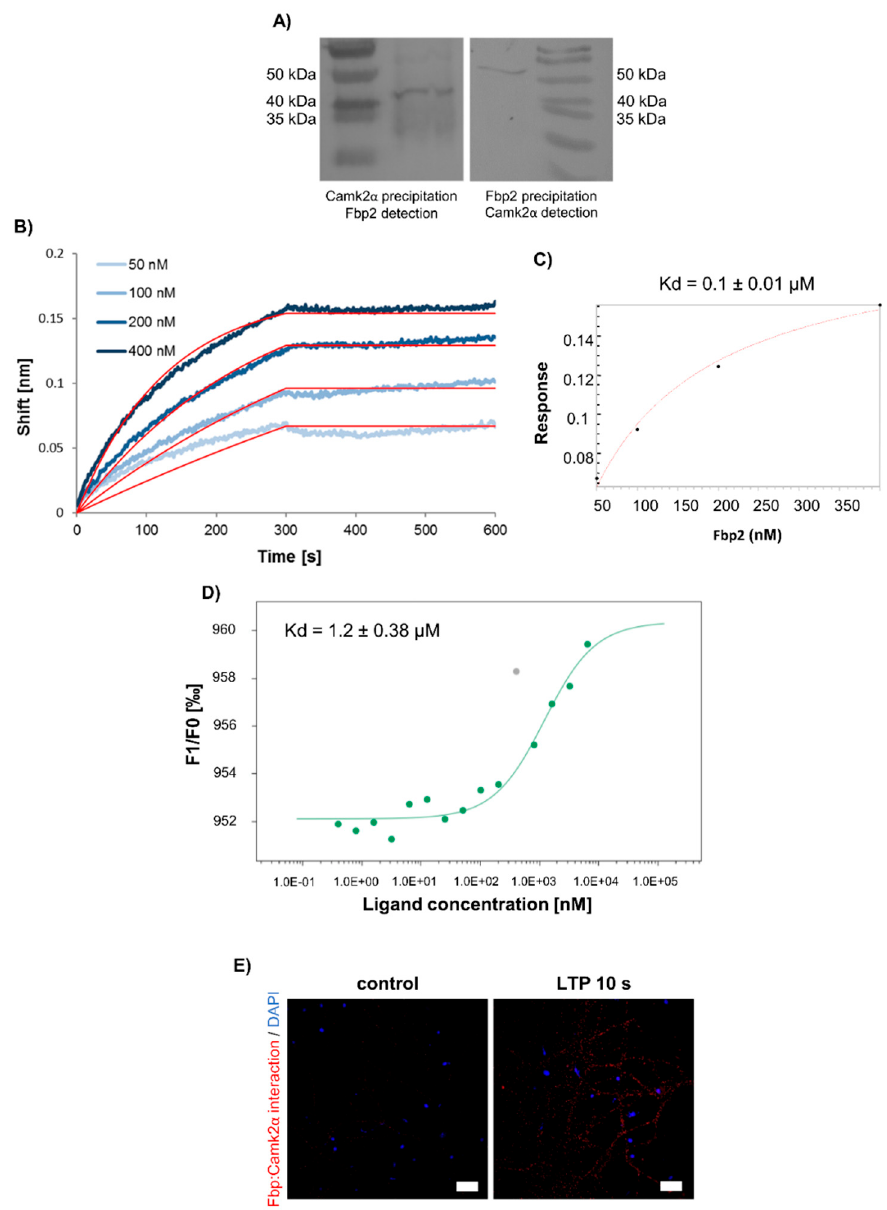
Figure 7. Fbp2 interacts with Camk2 α . ( A ) Co-immunoprecipitation of Fbp2–Camk2 α complex; the left image shows Western blot detection of Fbp2 after precipitation of the complex with anti-Camk2 α antibodies, while the right shows immunodetection of Camk2 α after the precipitation with the use of anti-Fbp IgG. ( B ) Biolayer interferometry (BLI) sensograms of Fbp2 binding to Camk2 α . The red lines represent global fit to the 1:1 interaction model. ( C ) Steady-state analysis of the Fbp2–Camk2 α interaction. ( D ) Fbp2 binds to Camk2 α (Kd = 1.2 µ M) as quantified using microscale thermophoresis experiments. ( E ) In situ detection of Fbp2 interaction with Camk2 α in 10 s after the LTP induction. Red spots indicate the places in which the enzymes interact with each other (Bar = 20 µ m).